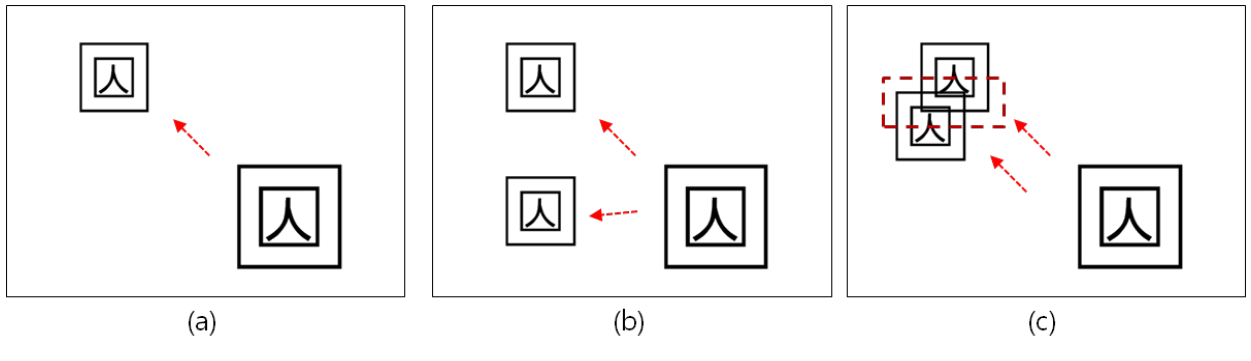
Figure 6. Deduction of markers overlapping problem.